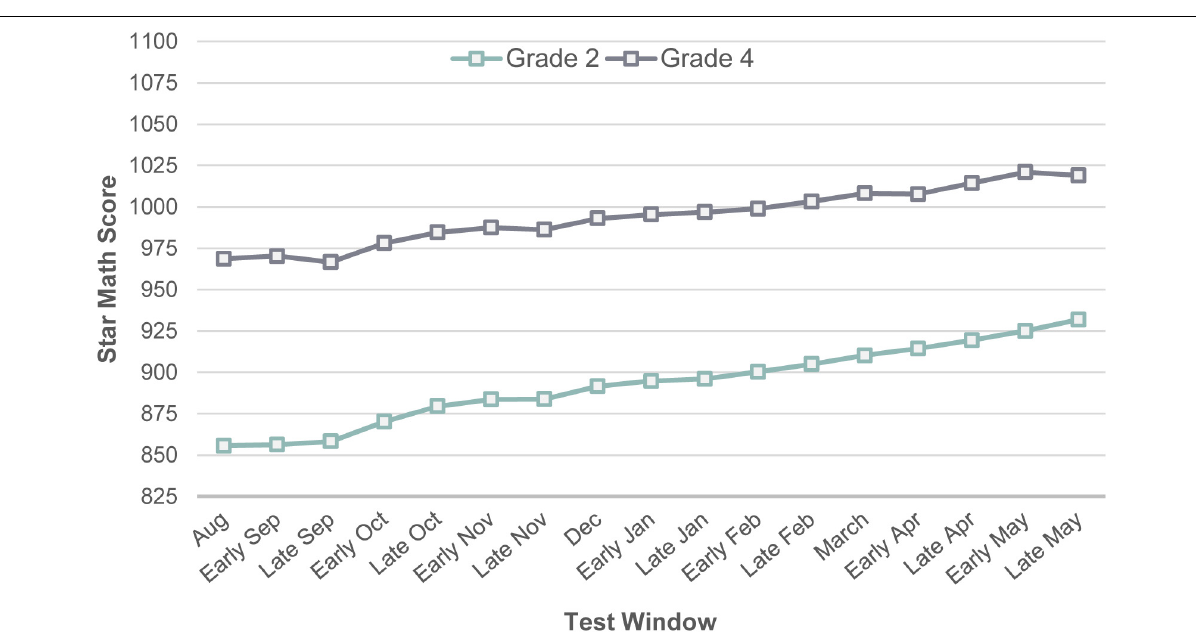
FIGURE 2 | Average Star Math scores by test